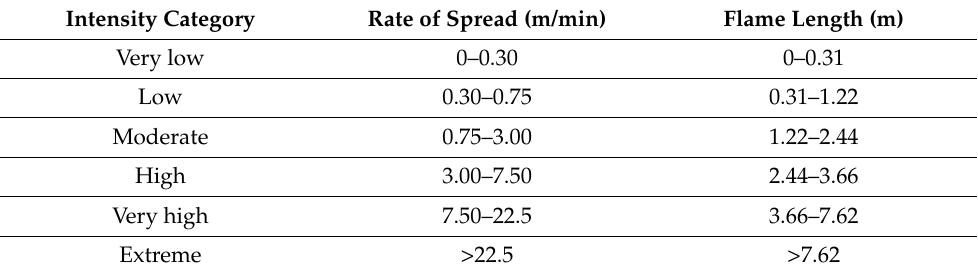
Table A1. Predictive fire behaviour intensity categories for surface fires. Adapted from [21].